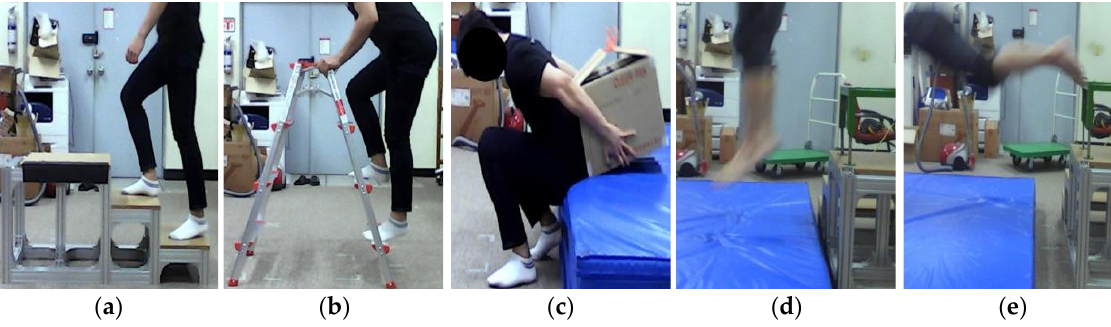
Figure 2. Examples of experimental motions: ( a ) climbing up and down stairs, ( b ) climbing up and down a ladder, ( c ) lifting (back), ( d ) 0.7 m jump, and ( e ) 0.7 m forward FFH.